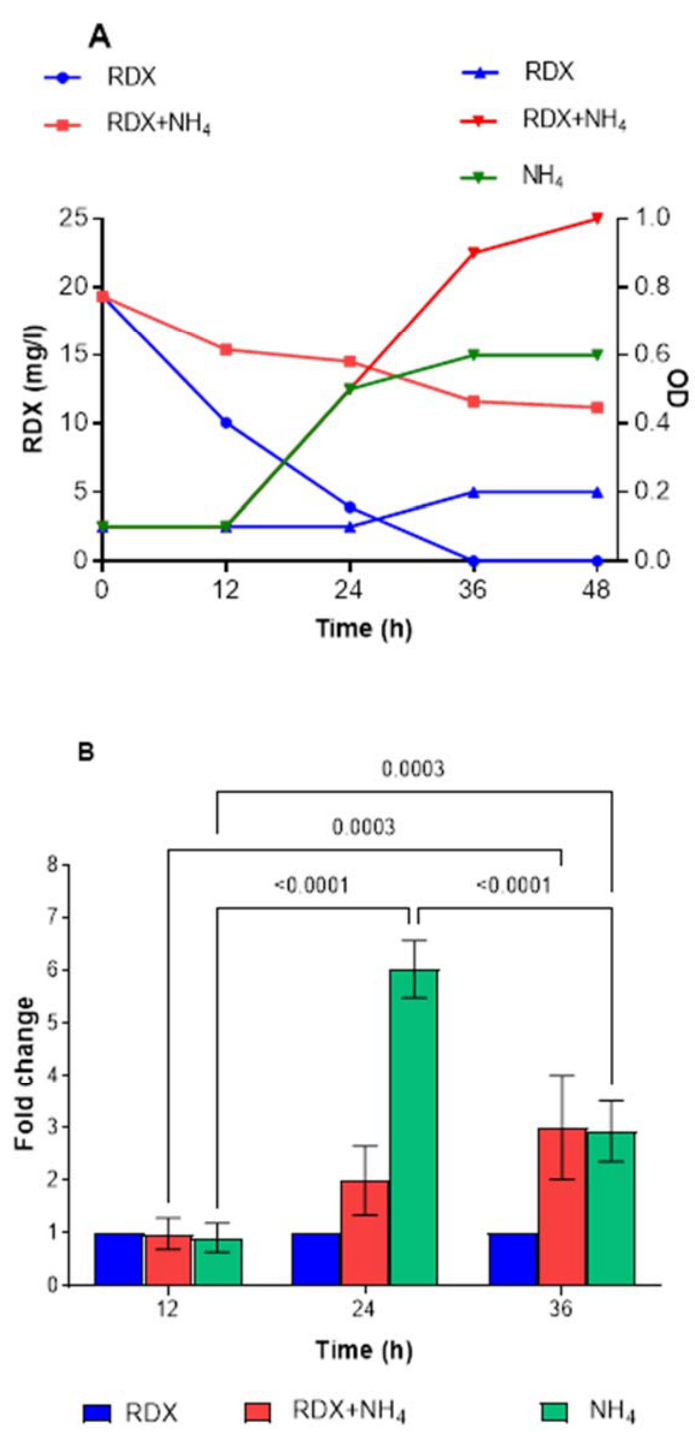
Figure 7. Degradation of RDX and growth of Rhodococcus strain YH1 in RDX, RDX + ammonium, and ammonium alone ( A ). Expression of xplA in strain YH1 in the presence of RDX, RDX + ammonium, and ammonium alone ( B ). Only significant p -values are